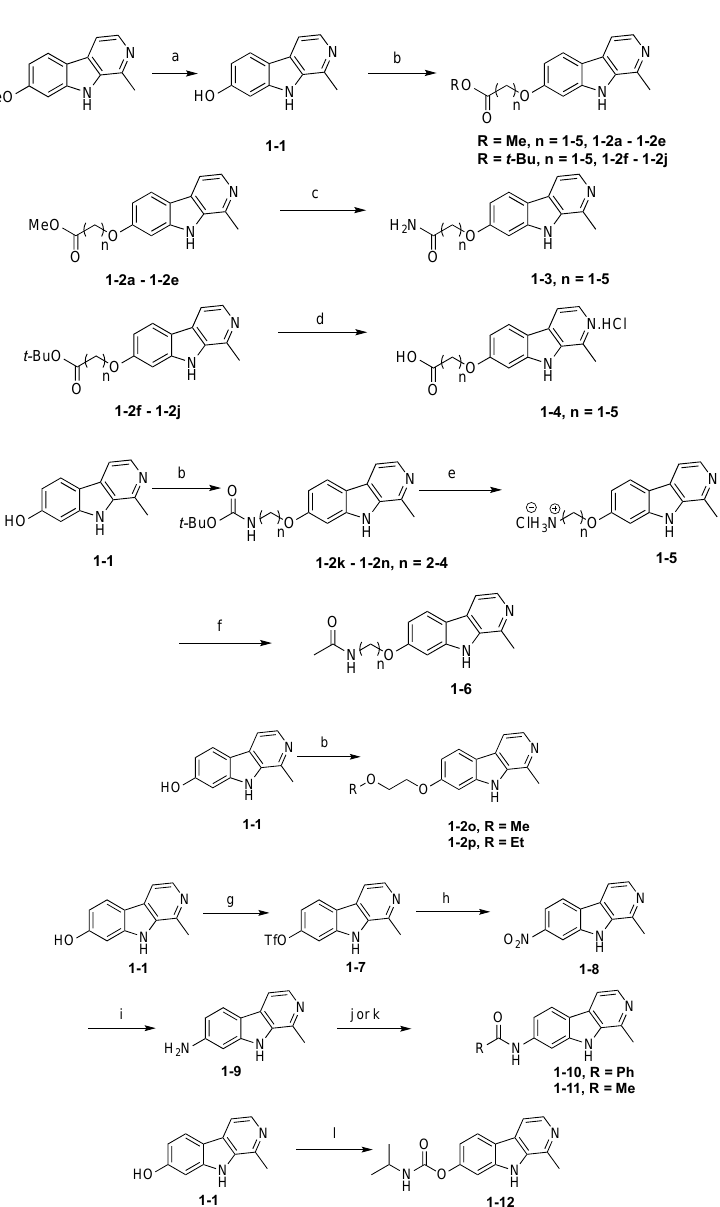
Scheme 1. Synthesis of 7-Substituted Harmine Analogs. Reagents and conditions: ( a ) AcOH, 48%